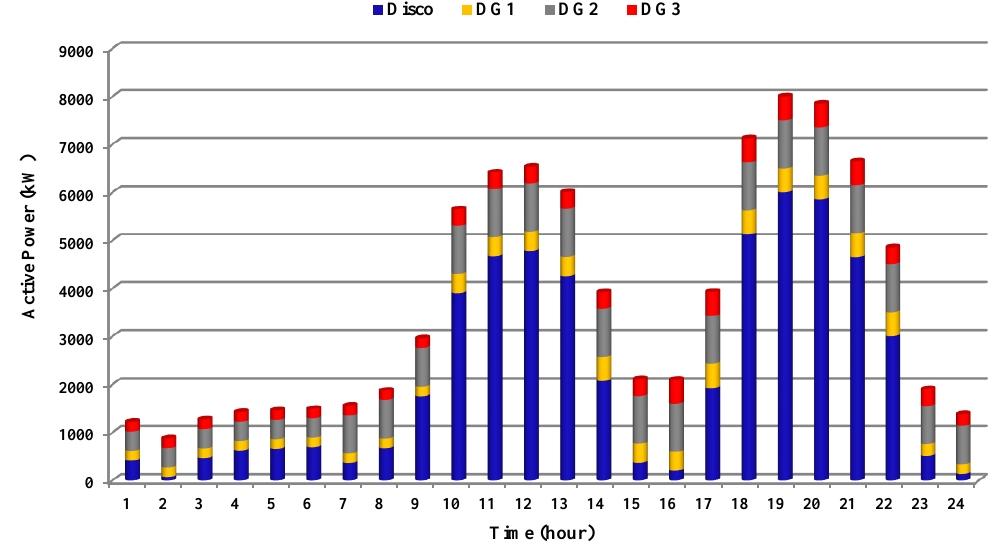
Figure 8. Daily optimal active power dispatches of generation units in Scenario 1.